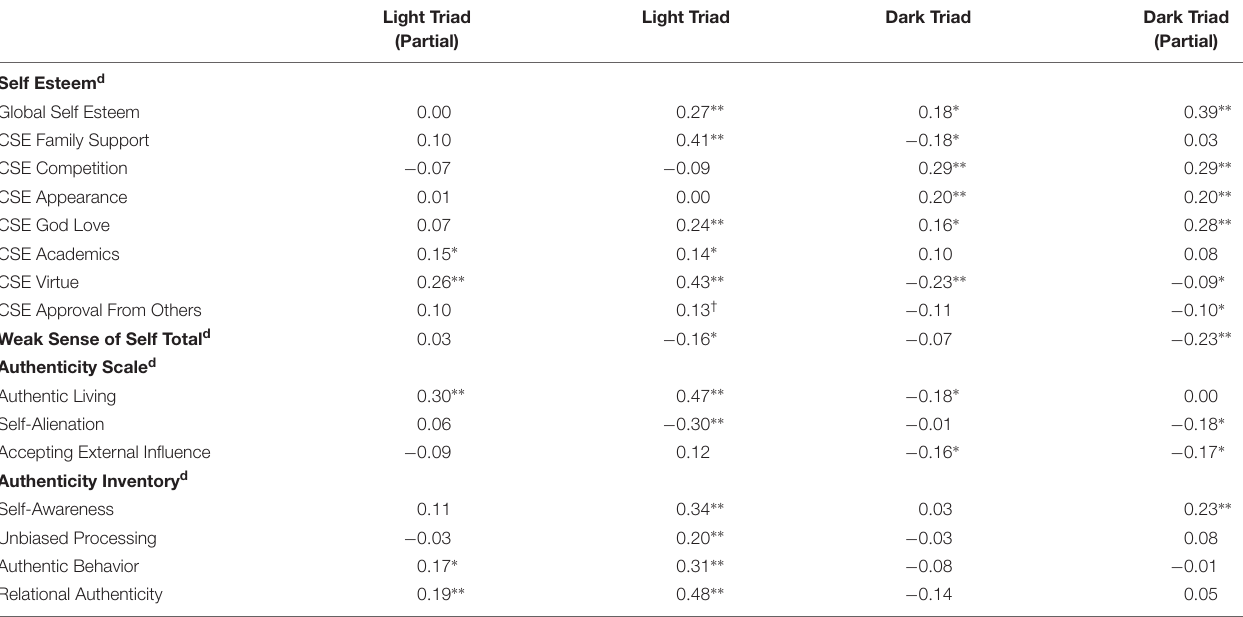
TABLE 11 | Correlations and partial correlations between self-esteem/authenticity and light vs. dark triad. Light Triad